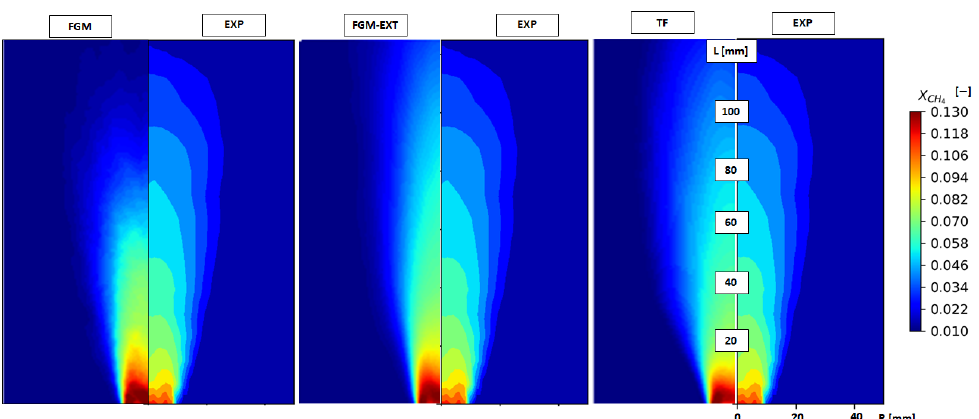
) from FGM, FGM-EXT, and TF compared 4